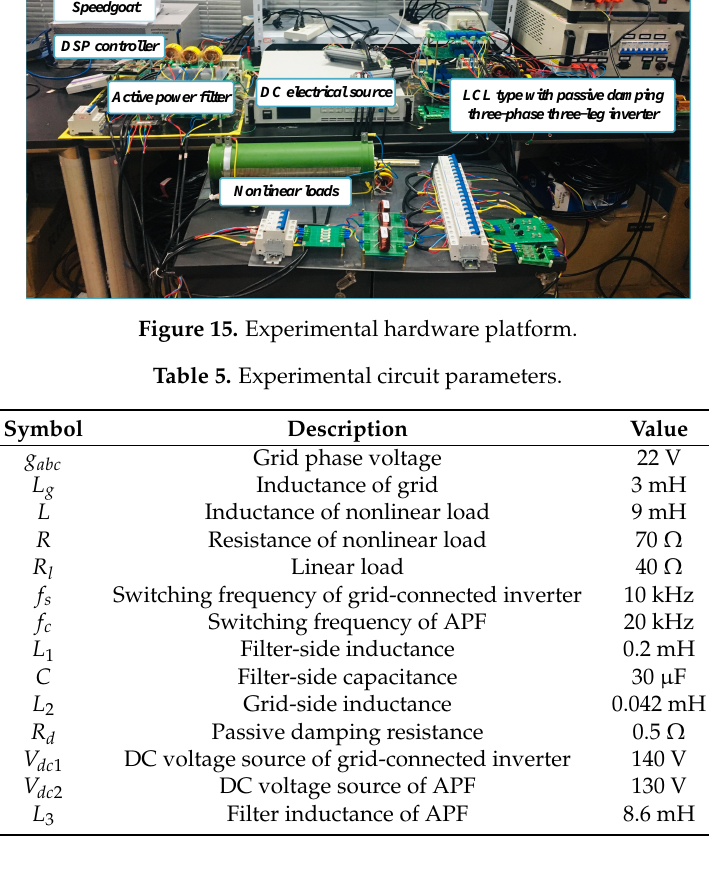
Table 6. Controller parameters in physical